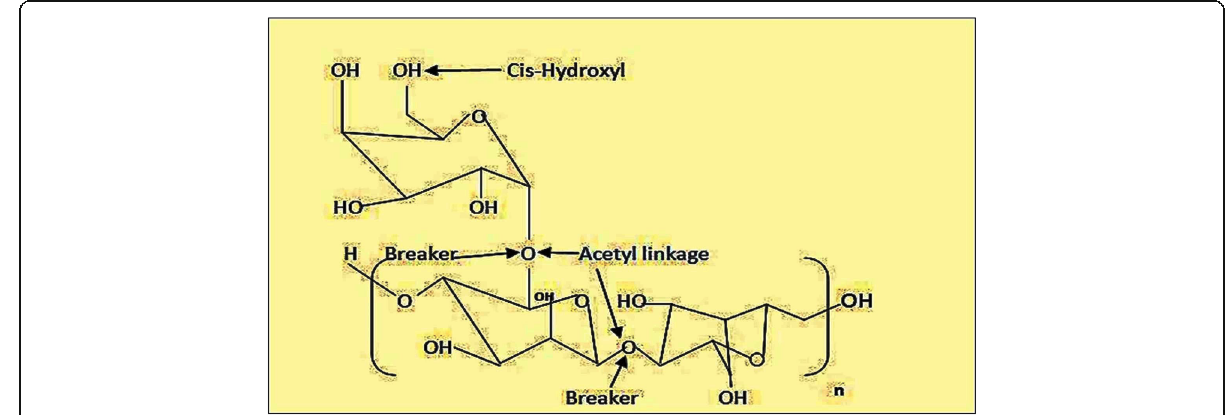
Fig. 5 Process of the breaking of linear gel